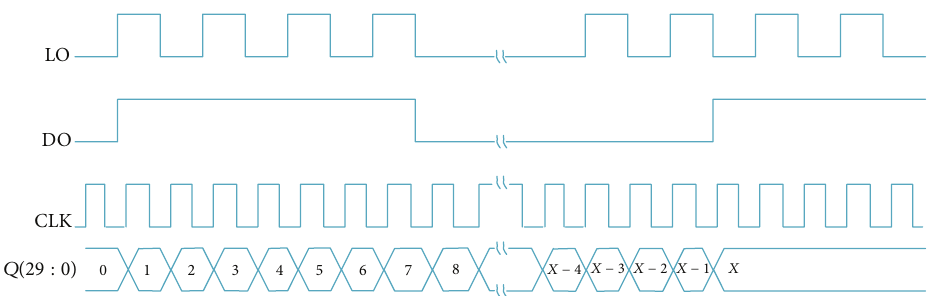
Figure 2: Timing diagram of the proposed FPGA-integrated TDC.